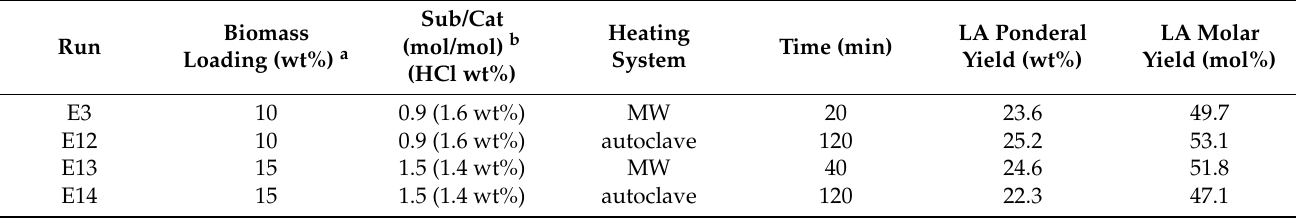
Table 4. Hydrolysis experiments on wet E cardoon sample adopting different heating systems, biomass loadings and substrate to catalyst molar ratios. Experimental conditions: 190 ◦ C, HCl as catalyst.